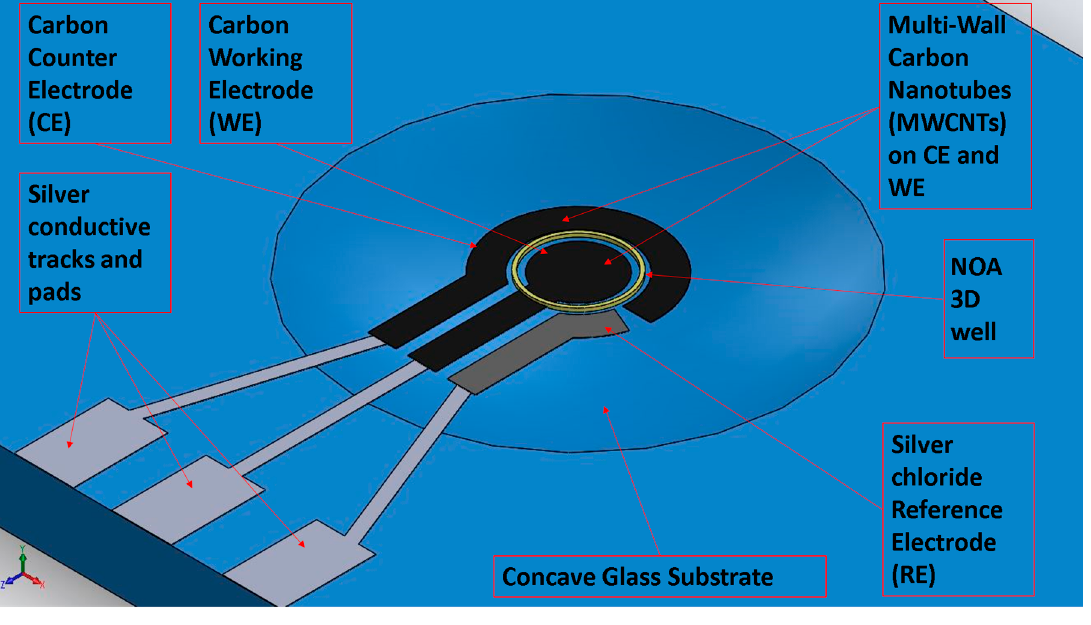
Figure 1. Schematic representation of the final prototype.